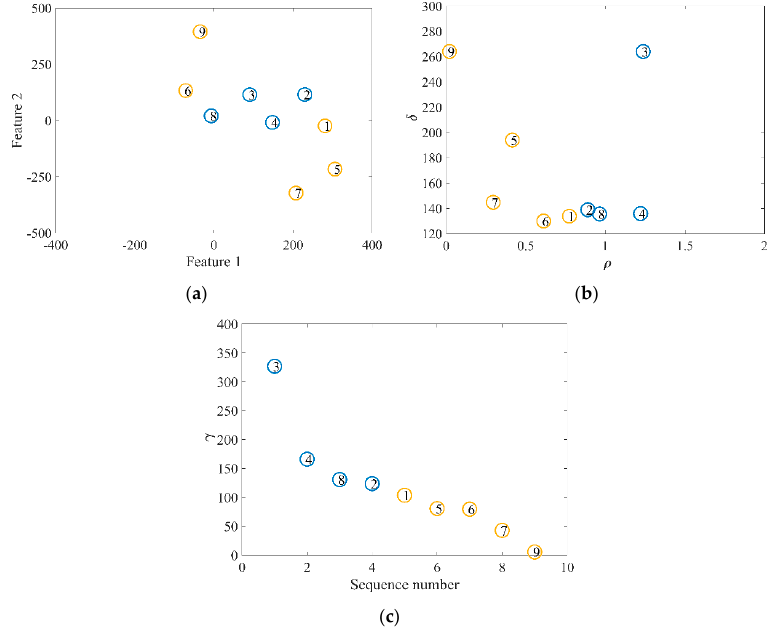
Figure 8. Process of searching the feature distribution center: ( a ) feature distribution of nine inverters; ( b ) decision graph; ( c ) the value of γ in decreasing order.